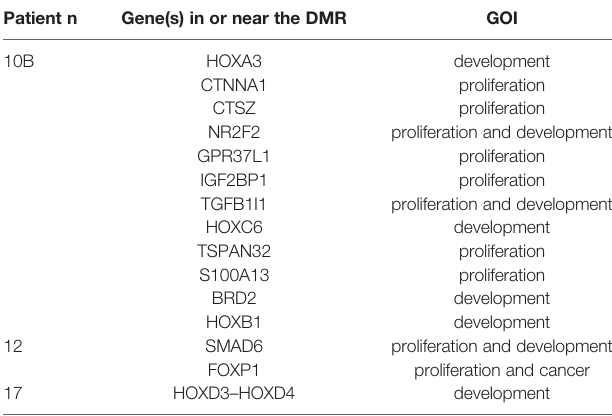
TABLE 4 | GOI close to signi fi cant DMRs elicited by the pairwise comparison between each malformed sample and the corresponding control tissue. Patient n Gene(s) in or near the DMR